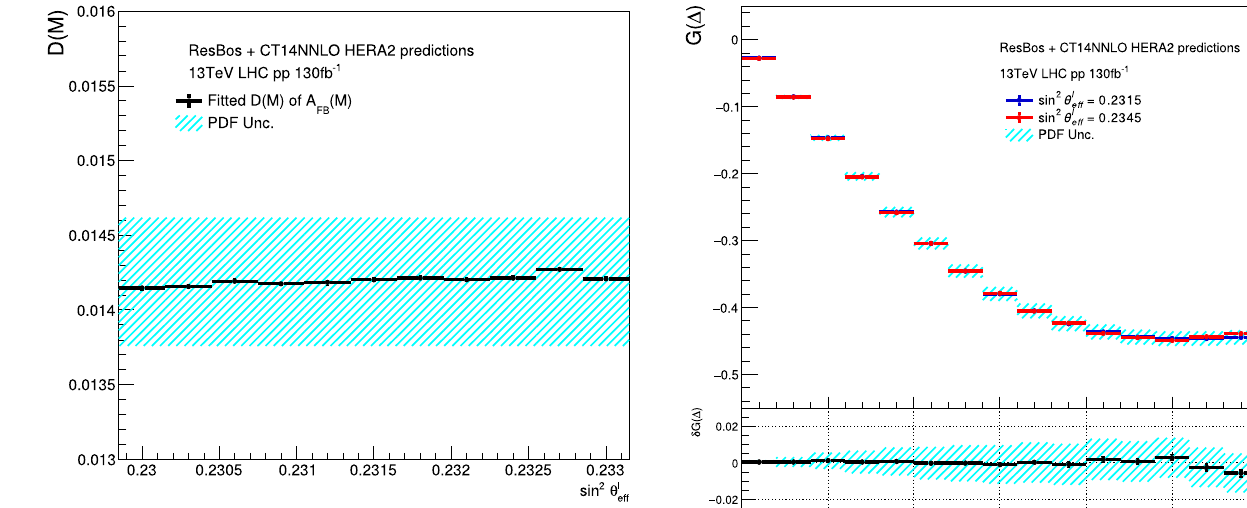
Fig. 3 Thefitted D ( M ) of A FB ( M ) inthe Z -poleregionof80 < M < 100 GeV, as a function of sin 2 θ (cid:4) . The error band corresponds to the eff PDF uncertainty of CT14HERA2, which is given at the 68% C.L. Error Fig. 4 Thevaluesoftheobservable G (Δ) withdifferentsin 2 θ (cid:4) bars are included for demonstrating the statistical fluctuation of 0.2345 and 0.2315, respectively, shown as a function of Δ and cal- culated with averaged A FB in a 2 GeV mass bin. In the bottom panel, the solid lines depict the difference δ G (Δ) of the two samples, while the error band corresponds to the PDF-induced uncertainty in G (Δ) 2 GeV mass bin in order to contain experimental conditions. calculated from CT14HERA2